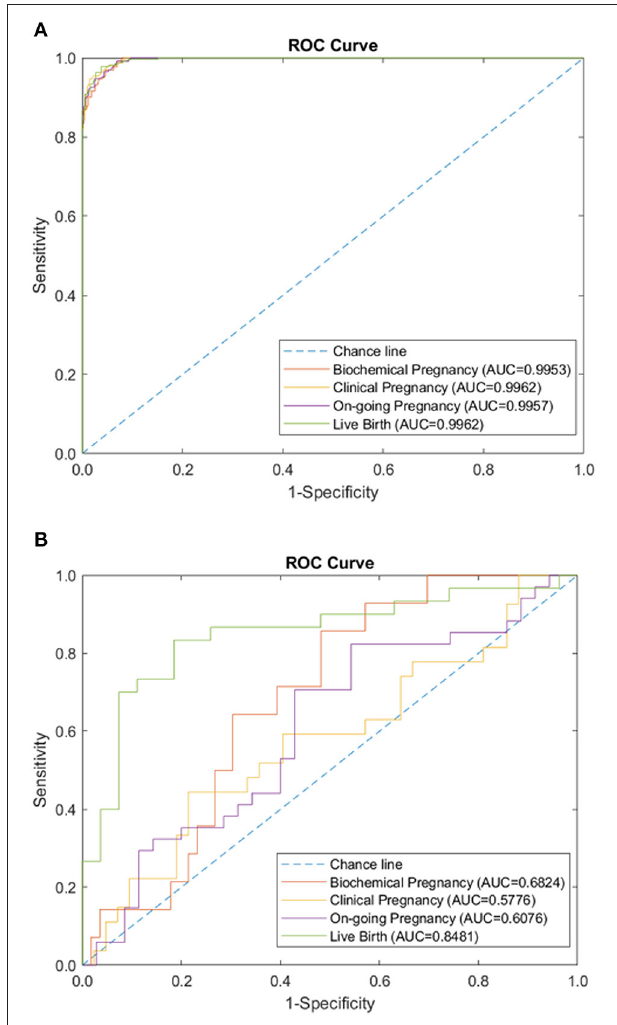
FIGURE 4 | Combination of immunology-related panels (autoantibodies, peripheral immunology, and endometrial immunology) performance of sparse coding in predicting pregnancy outcomes at different pregnancy periods. (A) ROC plot of the training data set. (B) ROC plot of the testing data